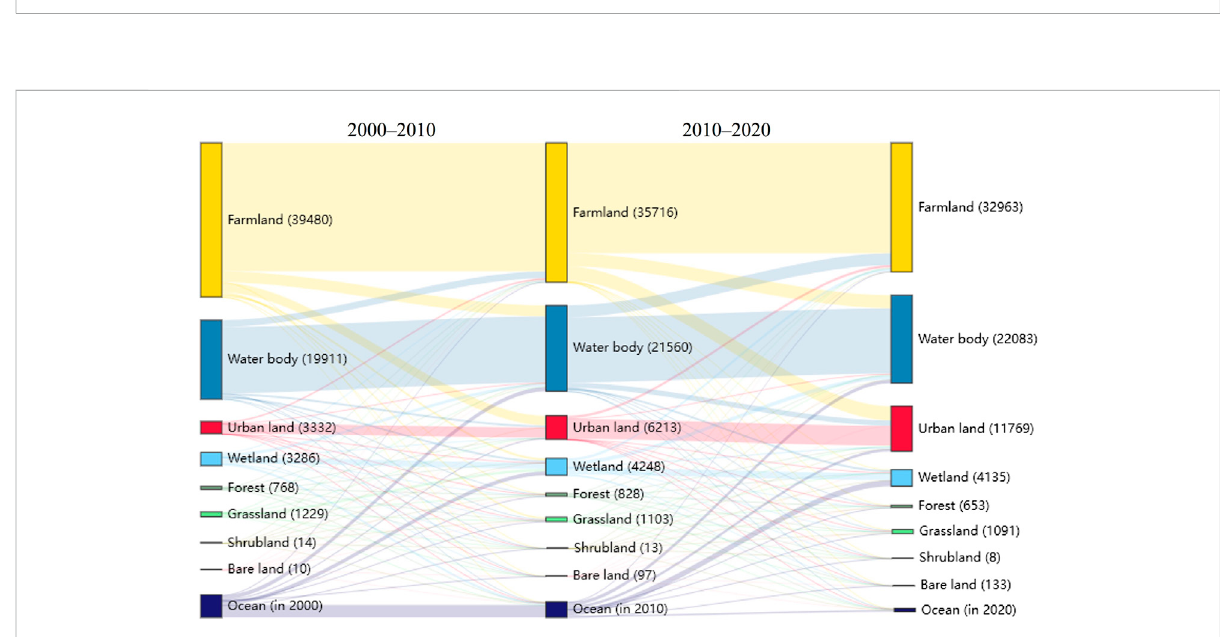
FIGURE 4 The land use conversions in CFAs during 2000 – 2020. Note: the height of each column represents the total area of a speci fi c land use type, which is presented in brackets (km 2 ); the width of each branch corresponds to the transferred land area.